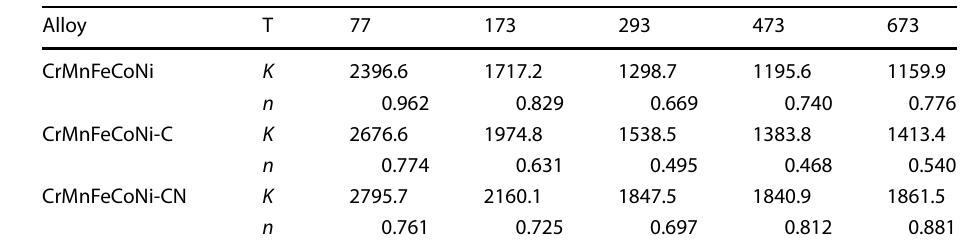
Table 3 Ludwik coefficients of the HEA in the plastic- deformation regime, according to Equation 1